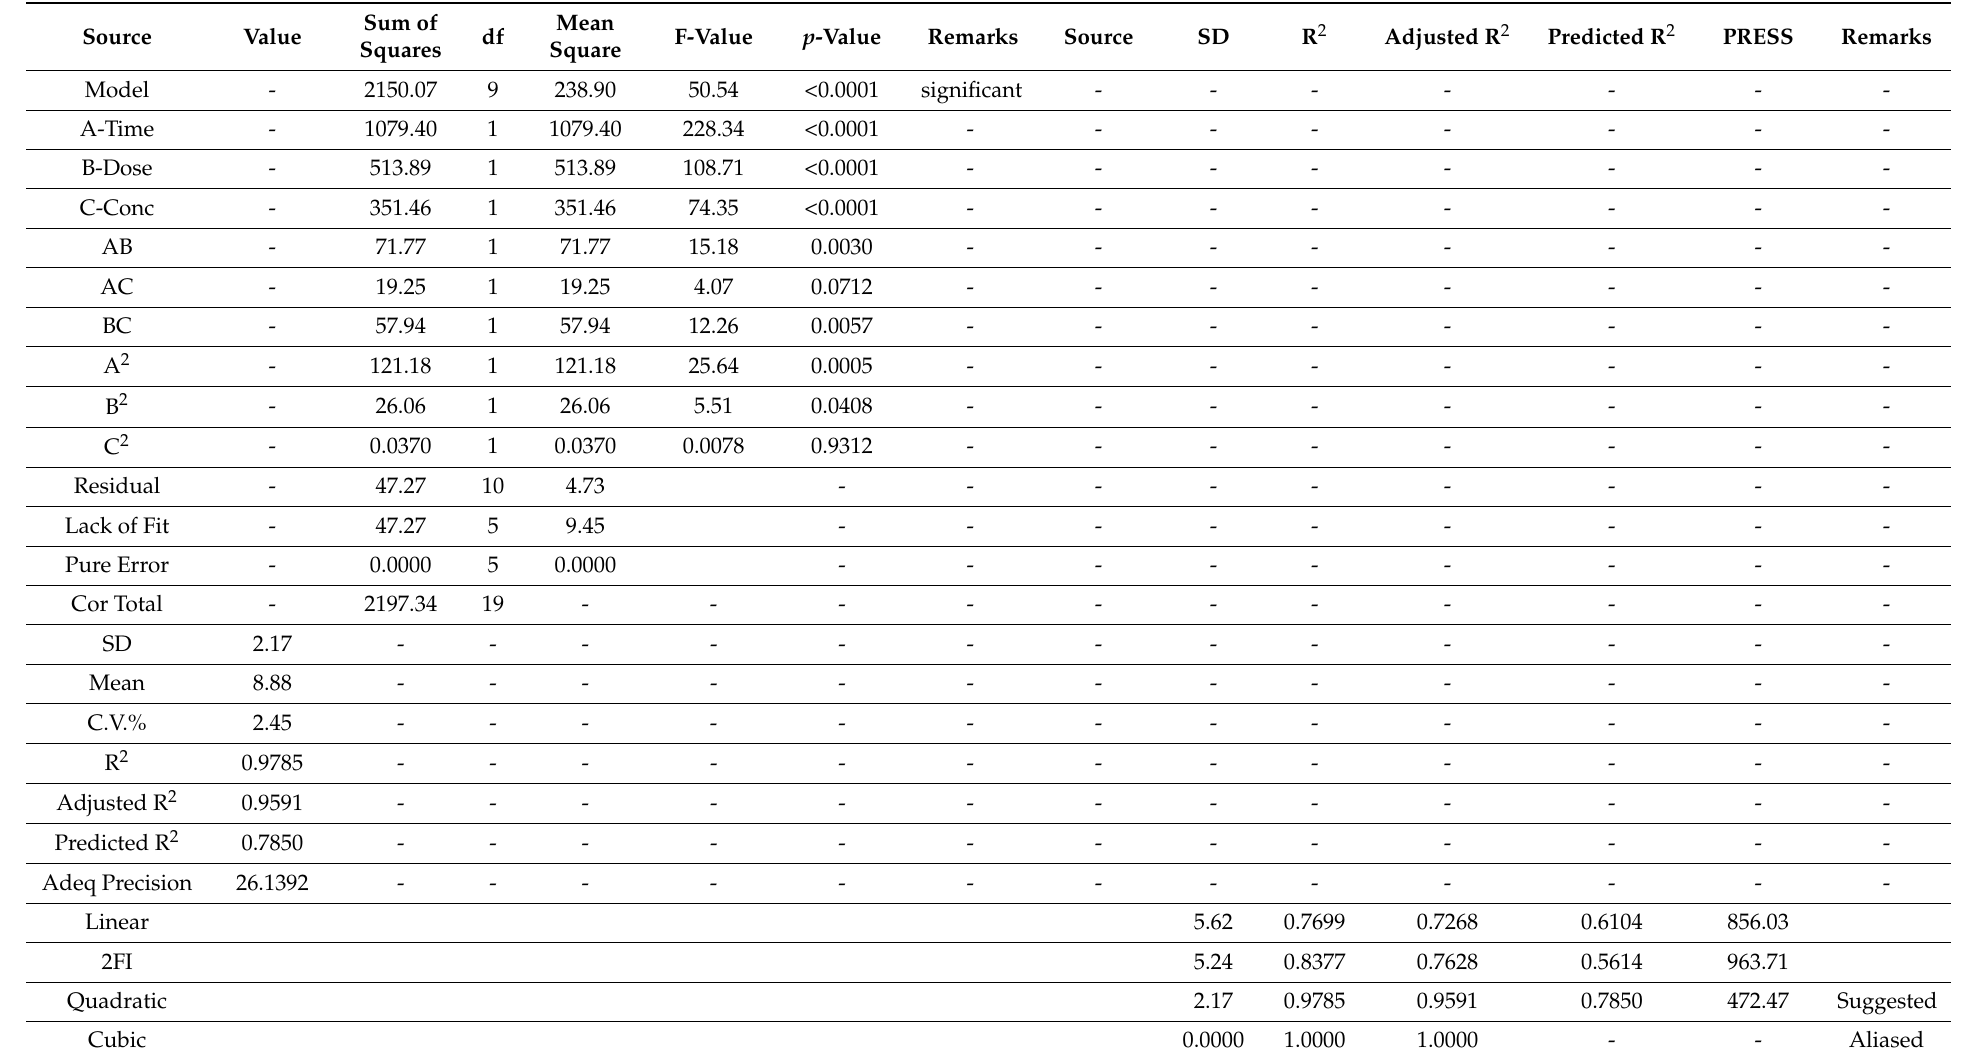
Table 7. ANOVA and model fit summary for D-optimal